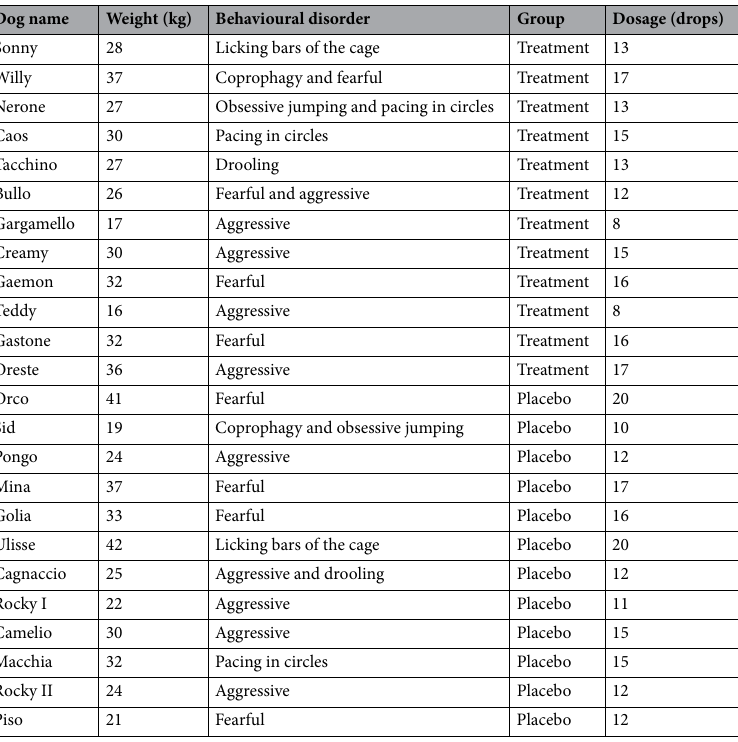
Table 1. The 24 dogs selected for the study, their weight, principal behavioural disorder, group and